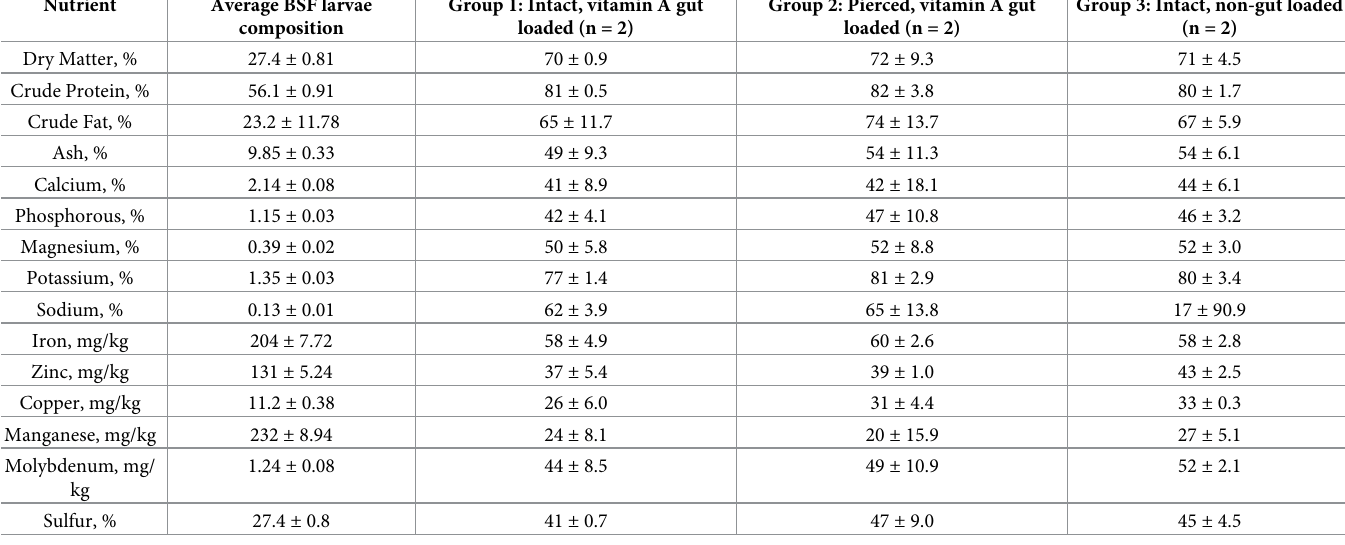
Table 1. Nutritional composition of BSF larvae and apparent digestibility coefficients for leopard geckos fed an exclusive diet of BSF larvae prepared in one of three ways. Nutrient